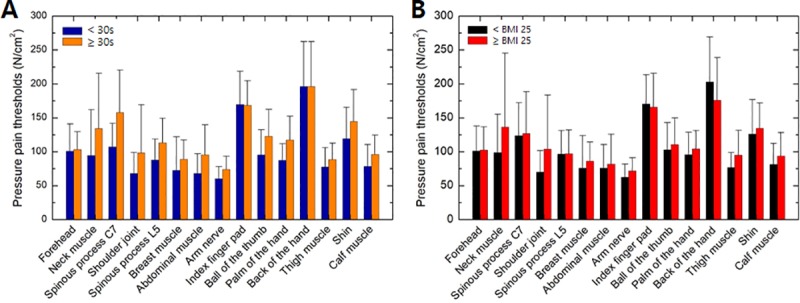
Variations in pressure pain thresholds by (A) age and (B) body mass index (BMI).